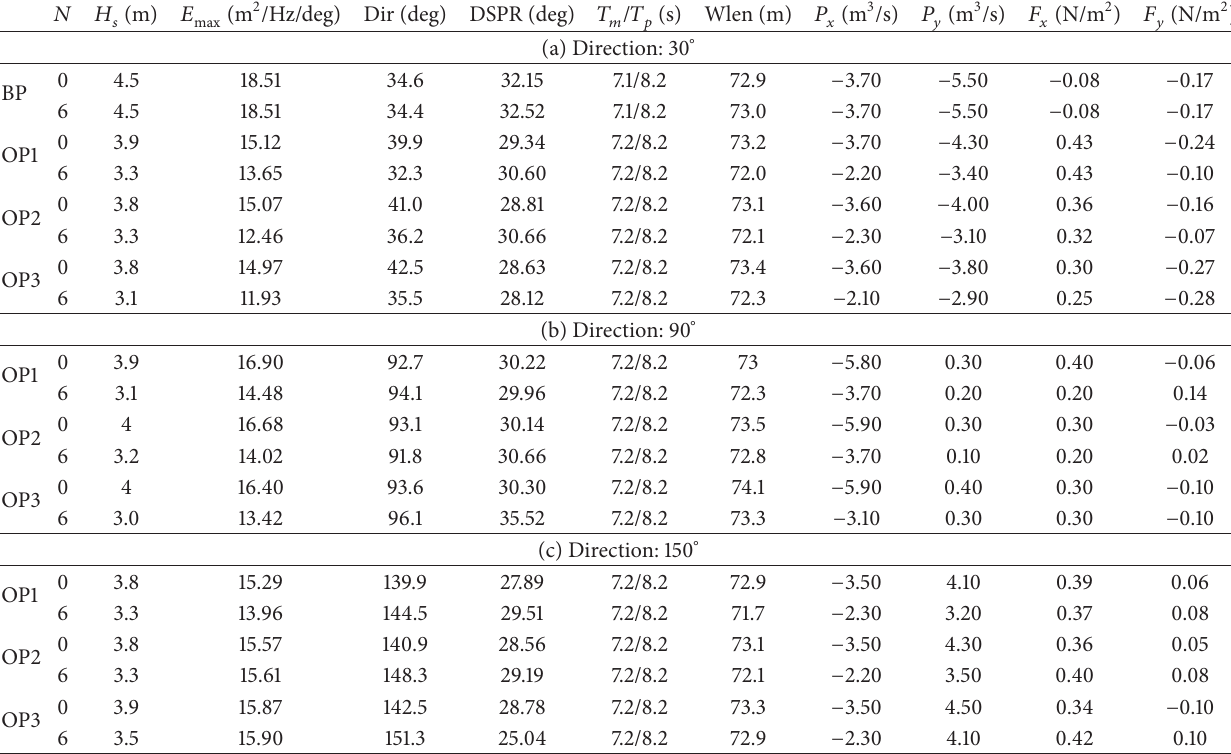
Table 6: Evaluation of the impact of the energy farms on the waves in the reference points OP1, OP2, and OP3 for the wave conditions (a) 𝑇 𝐻 𝑠 = 5m, 𝑚 = 8 s, and Dir = 30